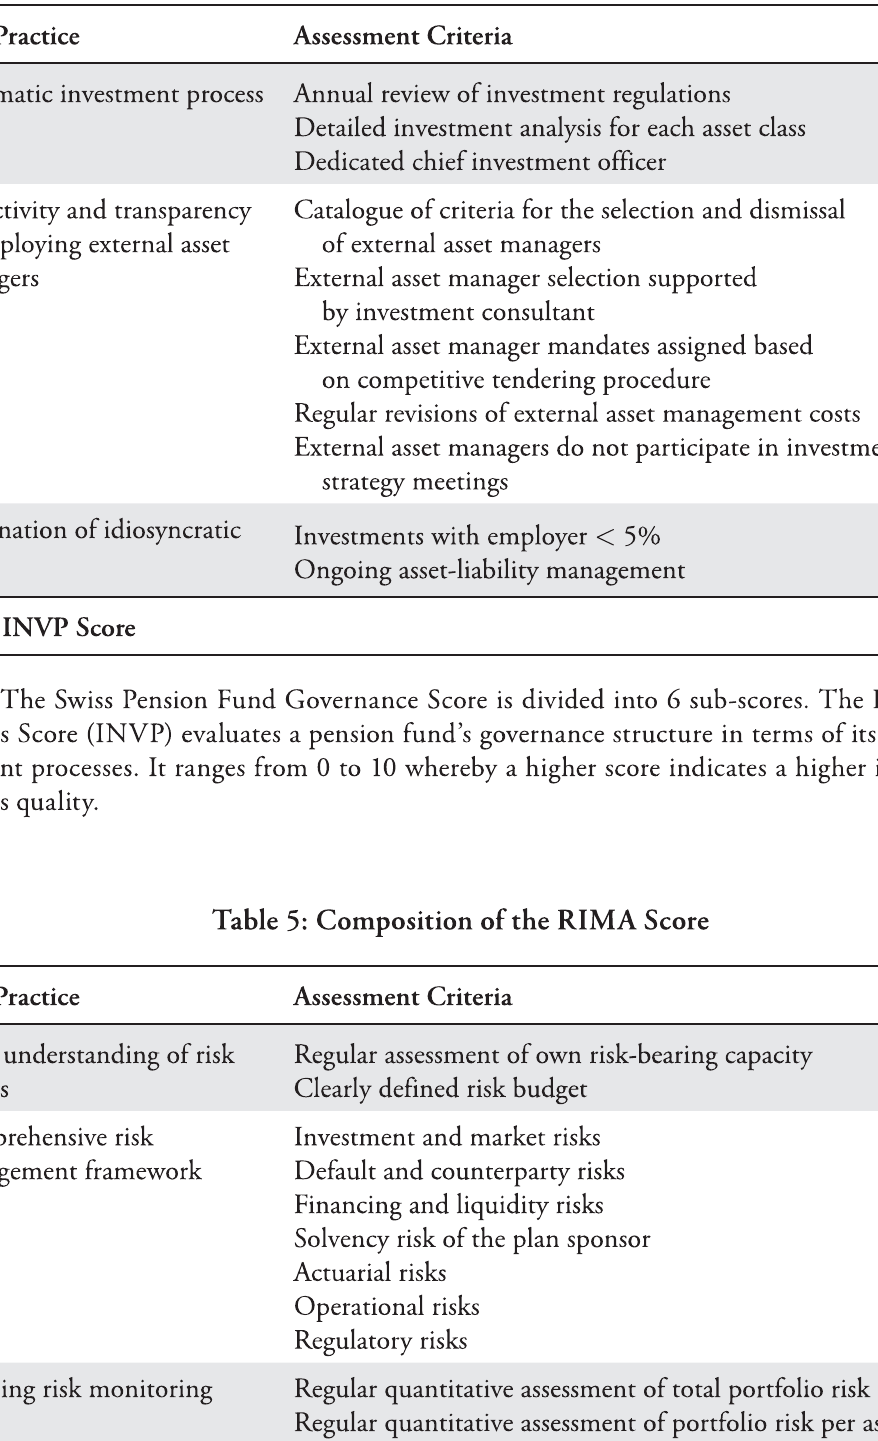
Table 4: Composition of the INVP Score